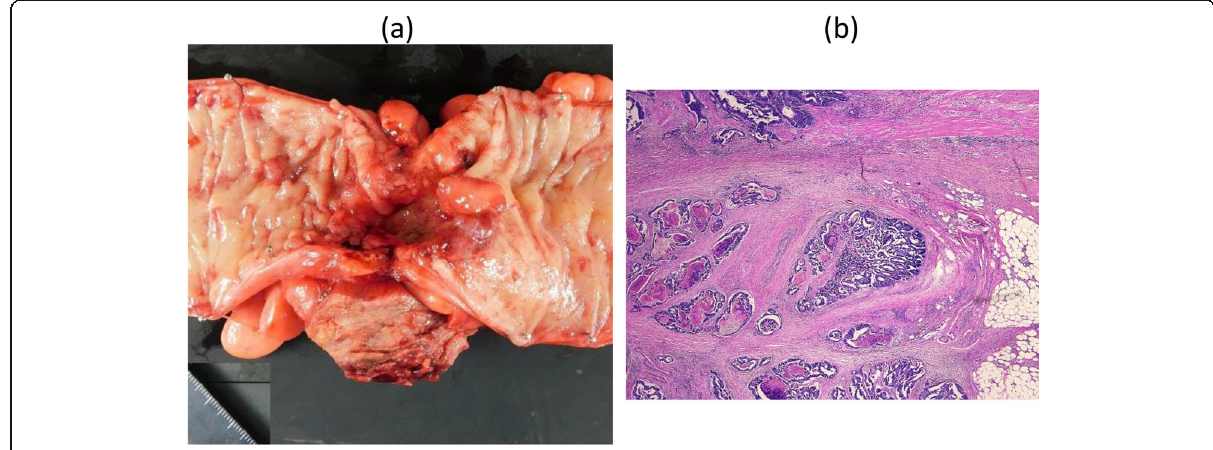
Fig. 4 a Macroscopic findings of the resected specimen showing a well-demarcated ulcerative protruding lesion. b Histological examination showed moderately differentiated adenocarcinoma invading the serosal layer (hematoxylin and eosin staining,